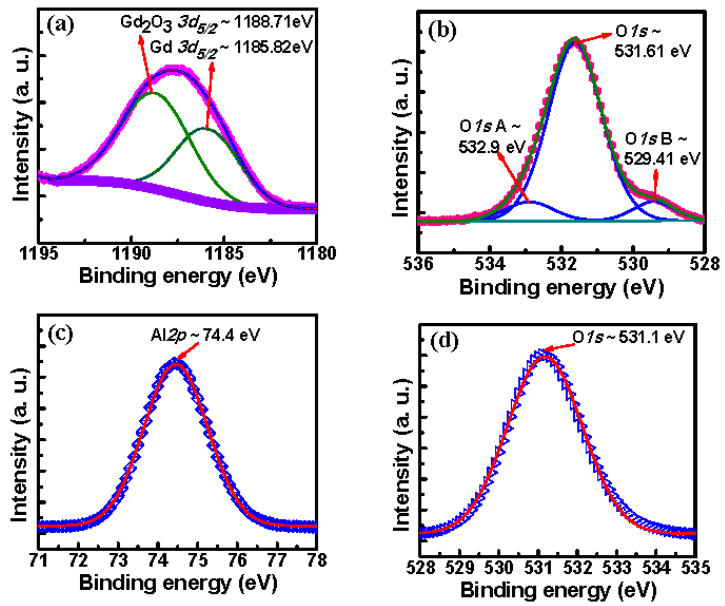
Figure 2. XPS analysis of the GdO x and Al 2 O 3 layers. ( a ) Gd 2 O 3 3d 5/2 spectra and ( b ) O 1s spectra in Gd 2 O 3 film, ( c ) Al 2p spectra and ( d ) O 1s spectra in Al 2 O 3 film on the SiO 2 /Si substrate.